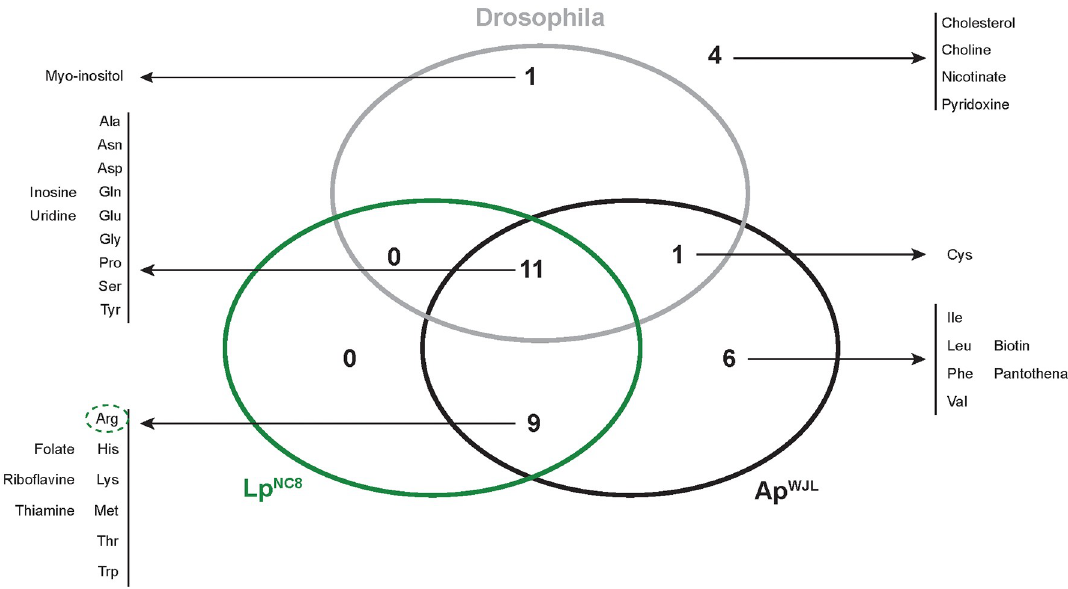
Fig 2. Drosophila , Ap WJL , and Lp NC8 have differential biosynthetic capacities of nutrients contained in the HD. Venn diagram represents the number of nutrients present in the FLYAA HD that can be synthesized by each organism. The list of corresponding metabolites is provided. Dotted circles: biosynthesis of this metabolite by Lp NC8 (green) may be possible but might be limiting. Ap WJL , A . pomorum WJL ; FLYAA, fly exome-matched amino acid ratio; HD, Holidic Diet; Lp NC8 , L . plantarum NC8 .